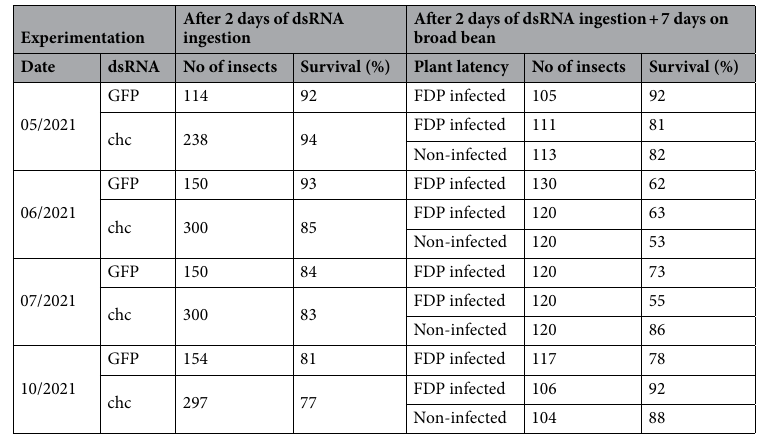
Table 2. Survival rates observed after two days of dsRNA ingestion by artificial feeding and 7 days after the insects were placed on FDP-infected broad beans or non-infected plants.